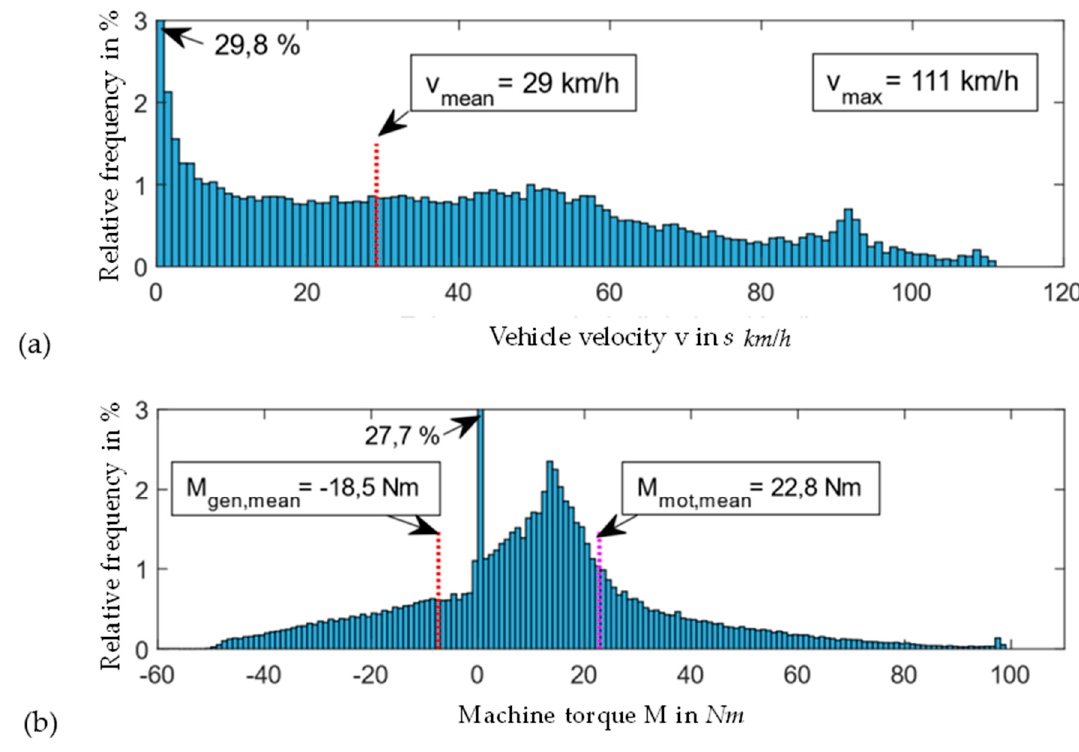
Figure 3. Vehicle speed ( a ) and machine torque ( b ) for the NEmo.